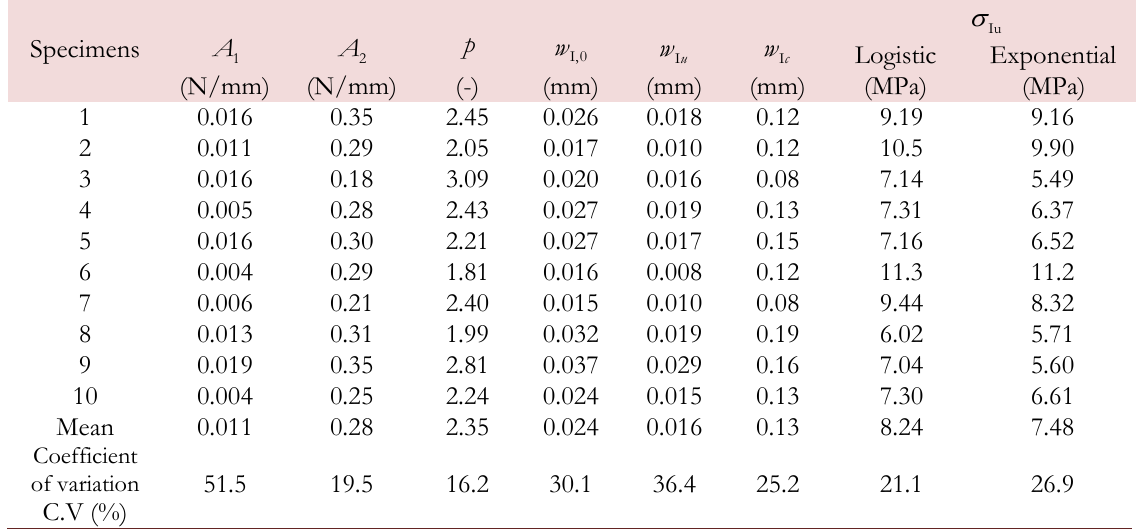
 ) and relative Iu